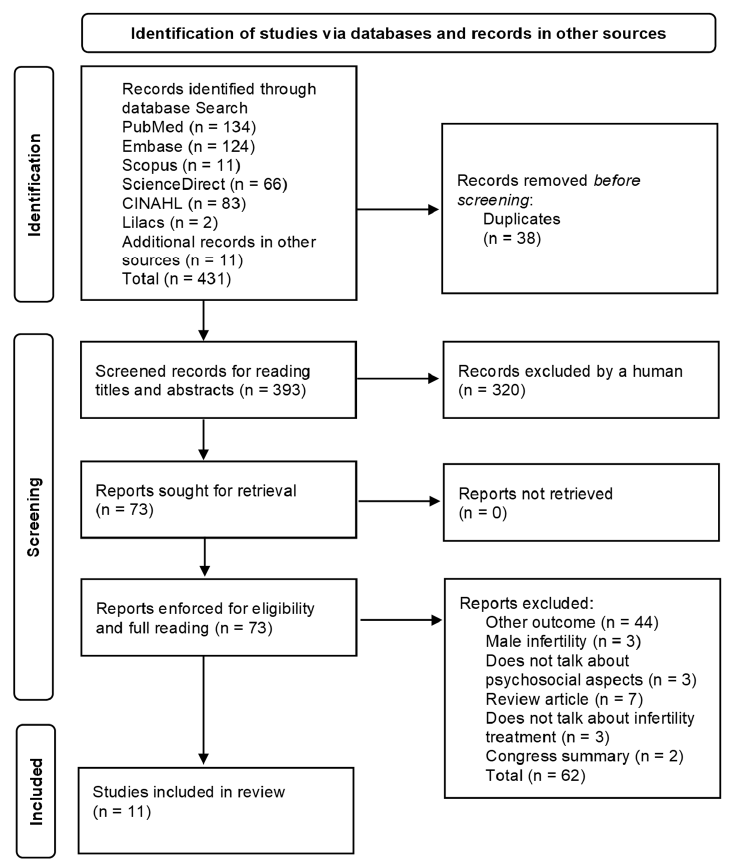
Figure 1. Study selection PRISMA flow diagram.